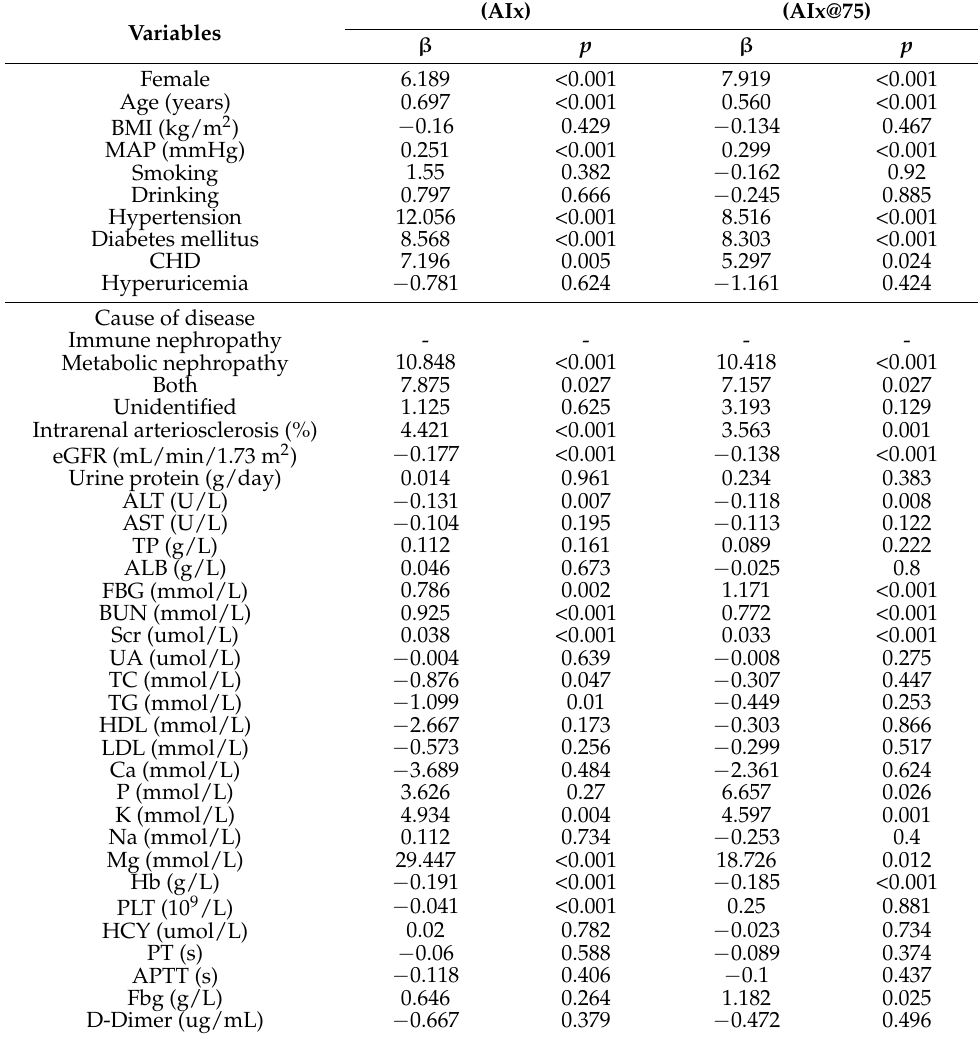
Table 3. Univariate linear regression analysis of factors related to arterial